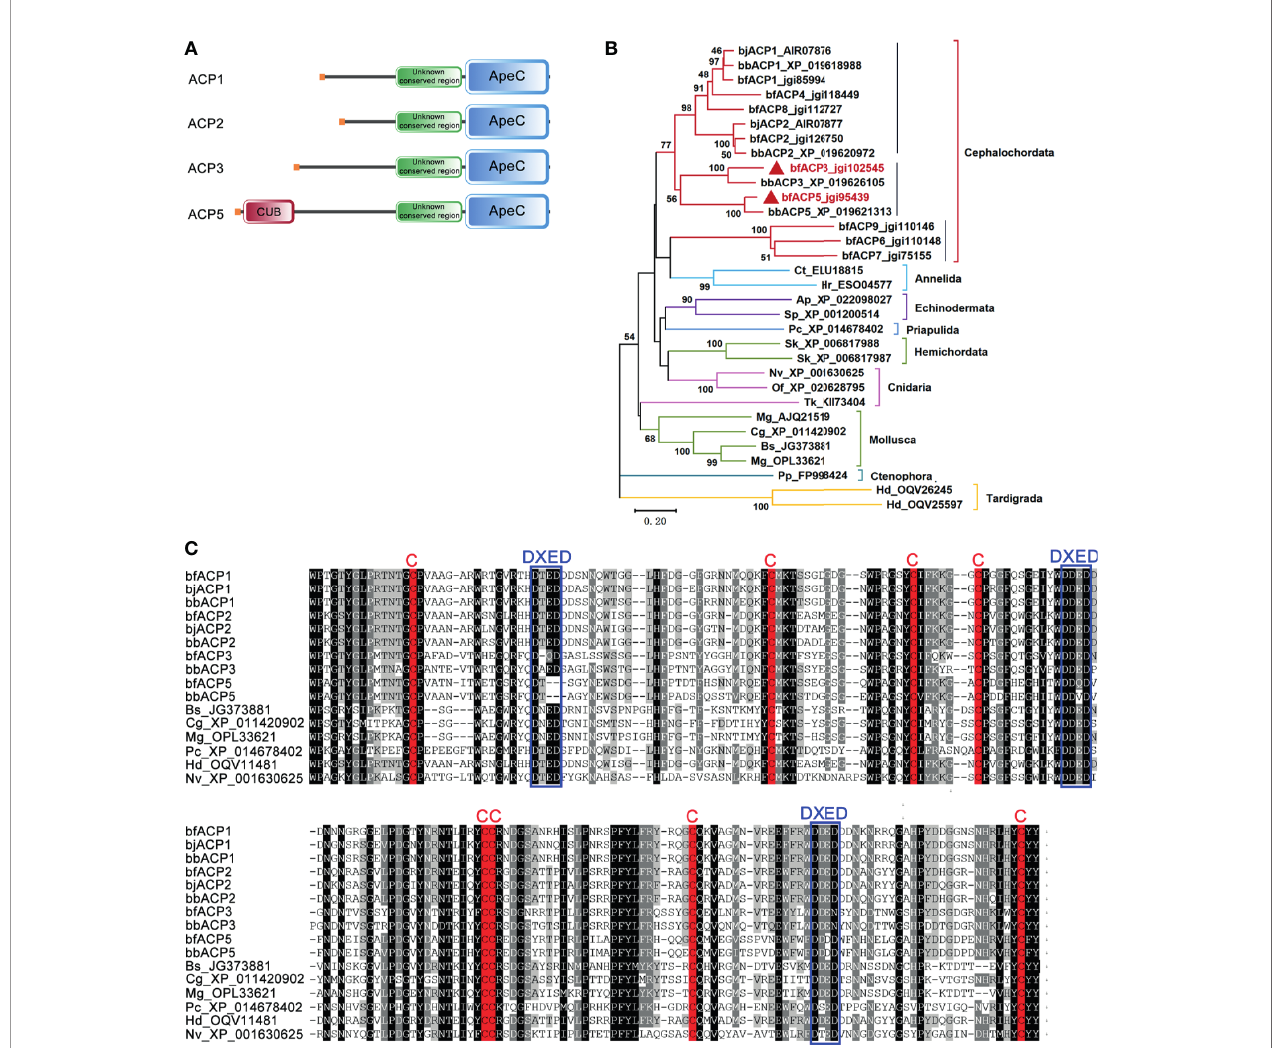
FIGURE 1 | Comparison of the amino acid sequences of bfACP3 and bfACP5 to other ACPs. (A) The domain architectures of amphioxus ACP3 and ACP5 compared with ACP1 and ACP2. (B) The phylogenetic tree of representative ACPs from different aquatic animal phyla based on the sequence of ApeC domains. The tree was constructed using the neighbor-joining method. Numbers on the lines indicate the percentage bootstrap values for 1000 replicates. The tree is drawn to scale, with branch lengths in the same units as those of the evolutionary distances used to infer the phylogenetic tree. A Maximum Likelihood tree based on the same alignment is provided in Supplementary Figure 4 and a more detailed version is shown in Supplementary Figure 5 . (C) Multiple alignment of the ApeC domains of ACPs from amphioxus and other aquatic species. The conserved Cysteine residues and DXED motifs are marked with red and blue boxes, respectively. bj, Branchiostoma japonicum ; bf, Branchiostoma fl oridae ; bb, Branchiostoma belcheri ; Bs , Botryllus schlosseri ; Cg, Crossostrea gigas ; Mg, Mytilus galloprovincialis ; Pc, Priapulus caudatus ; Hd, Hypsibius dujardini ; Nv, Nematostella vectensis ; Ap, Acanthaster planci ; Sp, Strongylocentrotus purpuratus ; Sk, Saccoglossus kowalevskii ; Tk, Thelohanellus kitauei ; Of, Orbicella faveolata ; Ct, Capitella teleta ; Hr, Helobdella robusta ; Pp, Pleurobrachia pileus